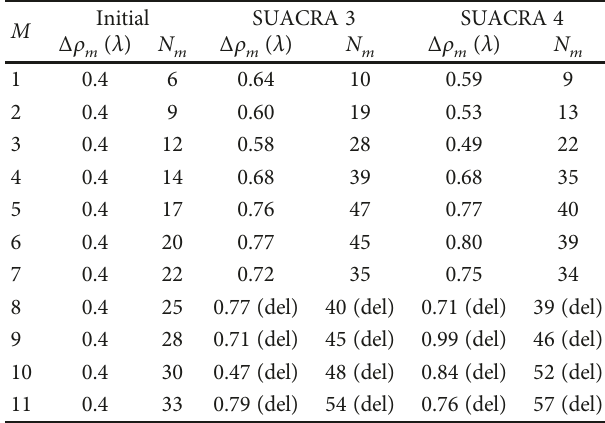
Table 4: Initial and optimized parameters of SUACRA 3 and